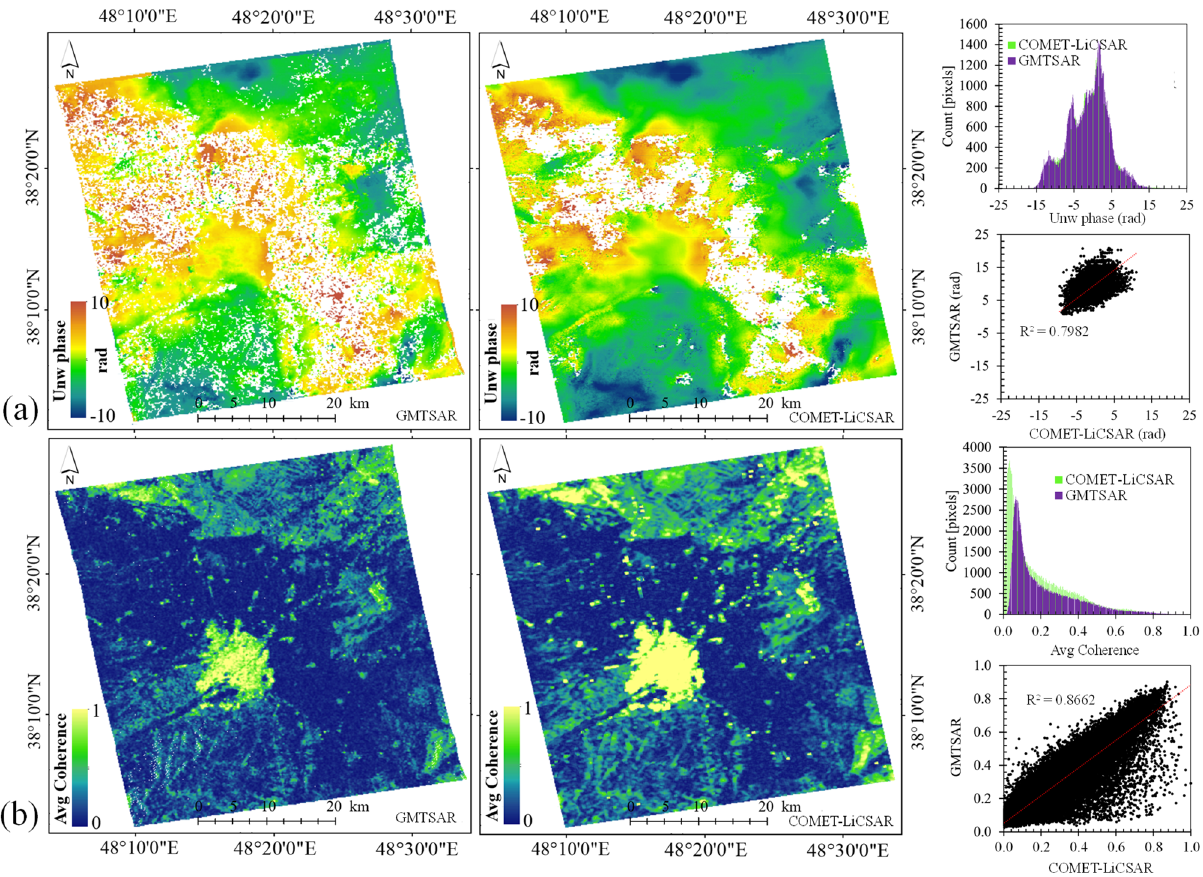
Figure 13. Comparison of the unwrapped interferograms and the coherence values used in GMTSAR and COMET-LiCSAR system: ( a ) The unwrapped phase pair 20170423–20170610. ( b ) The coherence pair 20170423–20170610. This figure was created using the QGIS version 3.14.0-Pi software (https:// qgis. org/ en/